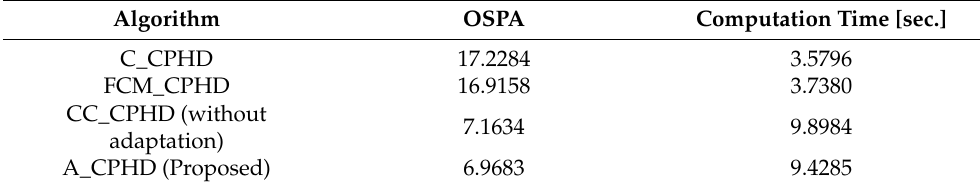
Table 2. The performance of tracking (case 2).